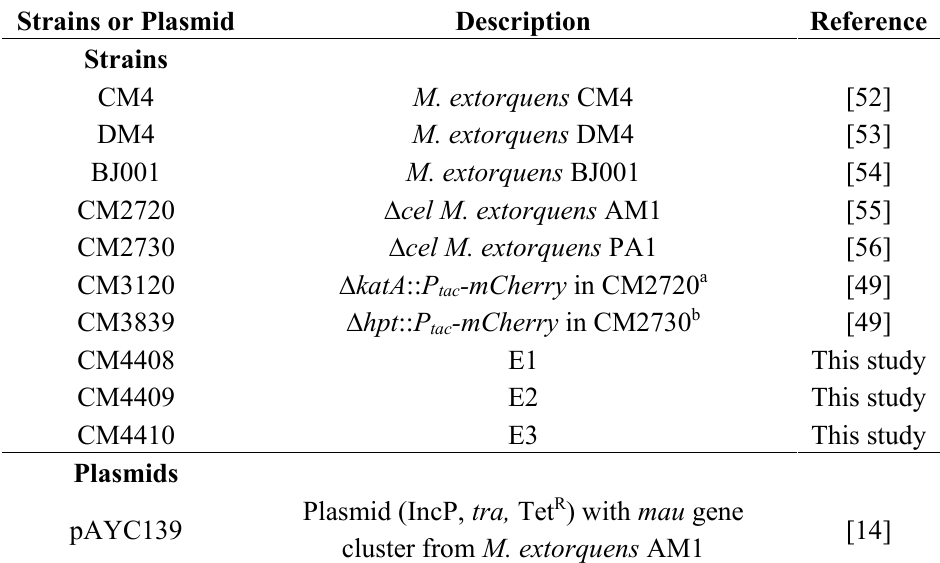
Table 1. M. extorquens strains and plasmids generated in this study. Strains or